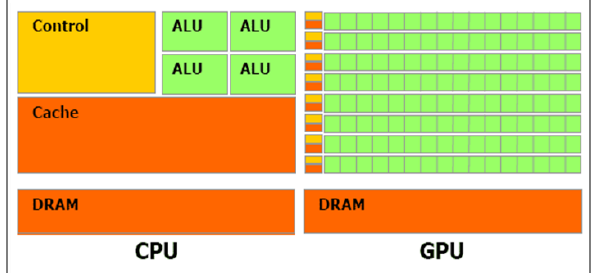
Figure 2 . Comparisons between CPU core and GPU core (Source: